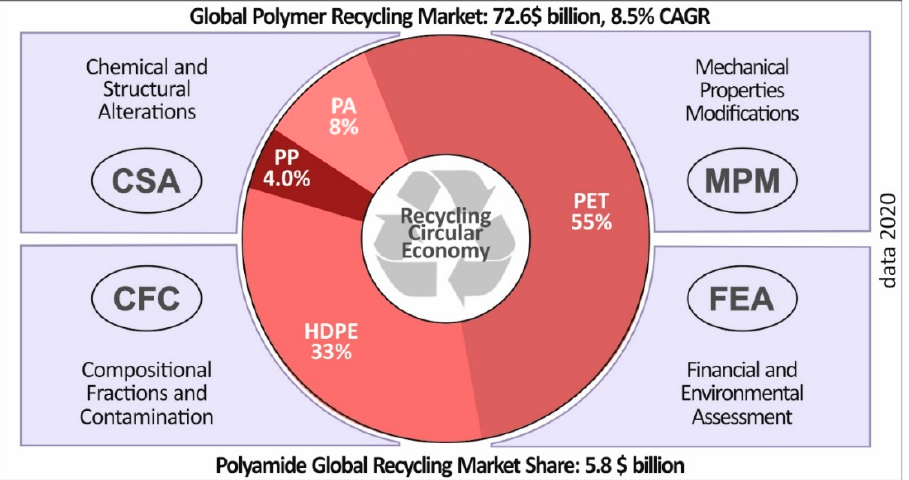
Figure 1. 2020 recycled plastics market and parameters affecting plastics circular economy (market volume data source: Technavio. Global Recycled Plastics Market 2020-2022 (IRTNTR21968).